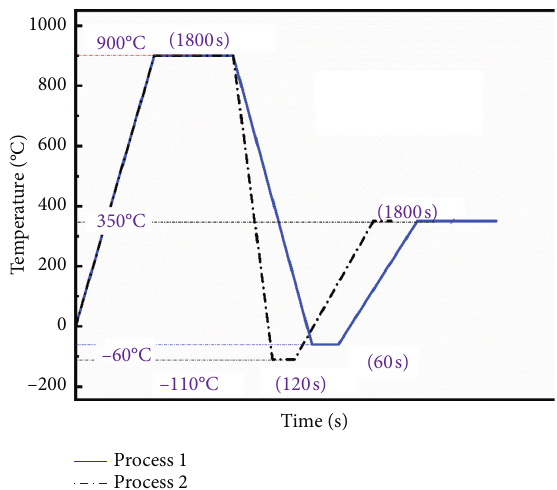
Figure 3: Process graph of cryogenic treatment and